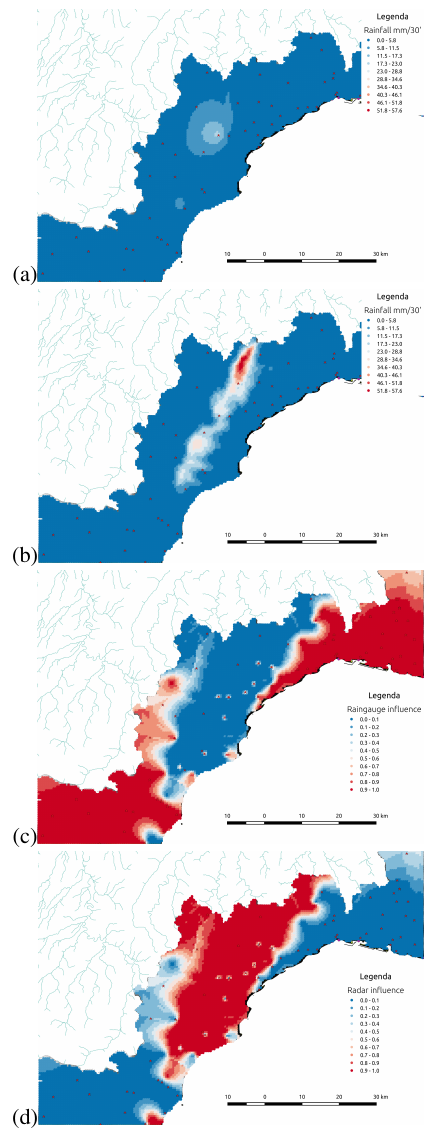
Figure 5: Ordinary kriging approximation of rainfalls computed with (a) rain gauges and (b) integrated with radar measurements. (c) Rain gauges weights and (d) radar data set mapped in